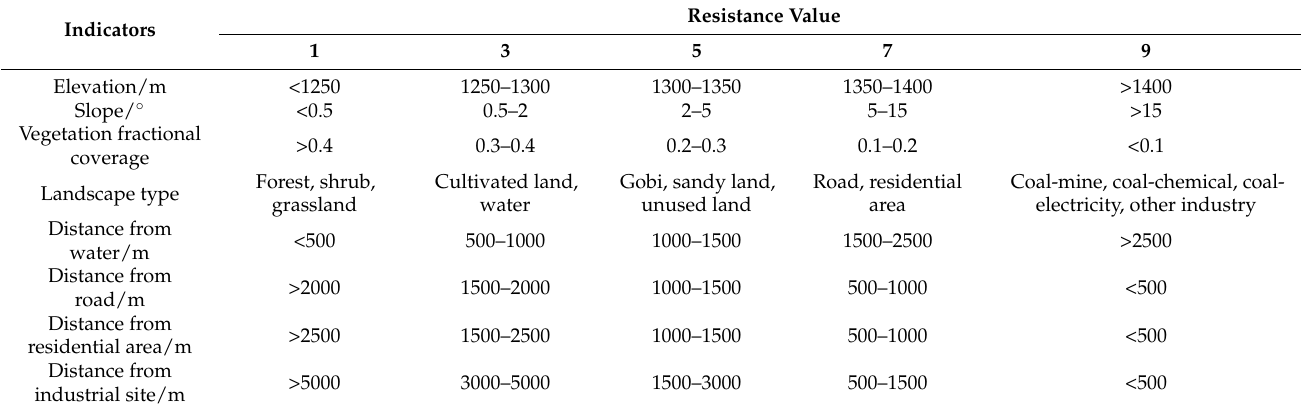
Table 3. Classification of the ecological resistance